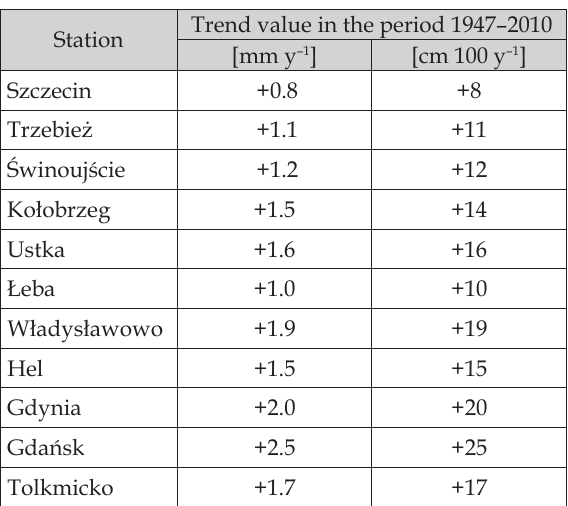
Table 4. Trend values of observational series sea-lev- el in the period 1947–2010 for tide gauges stations of the Polish